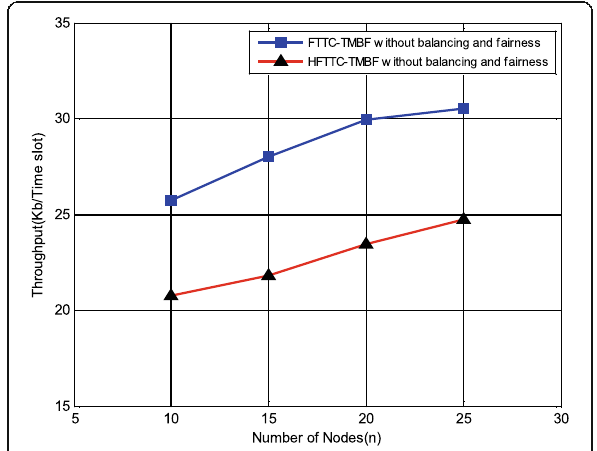
Fig. 6 The comparison of throughput in FTTC-TMBF and